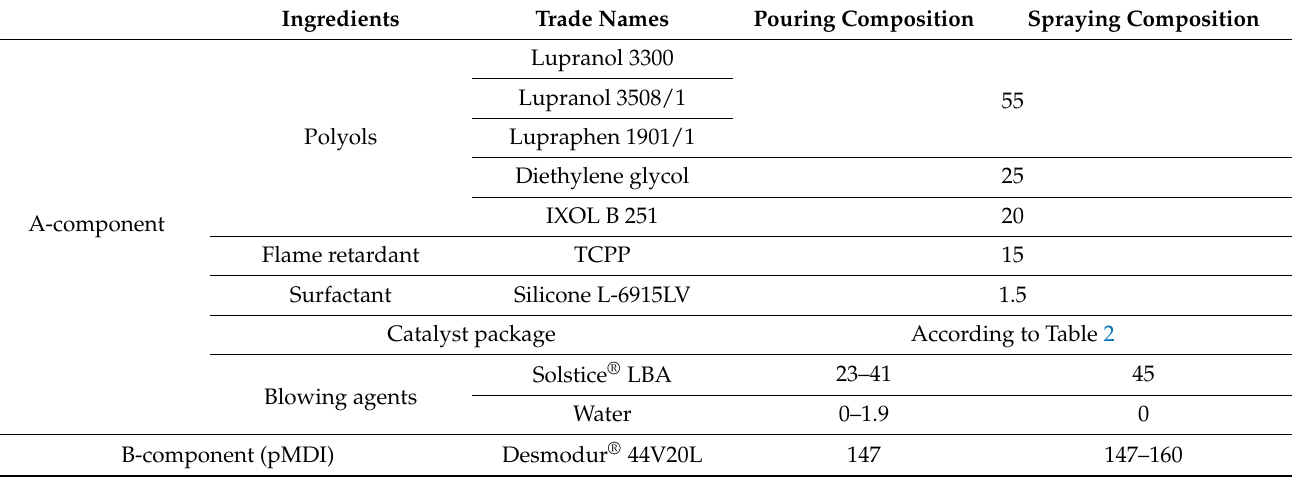
Table 1. Recipes of PUR pouring and spraying compositions, pbw.